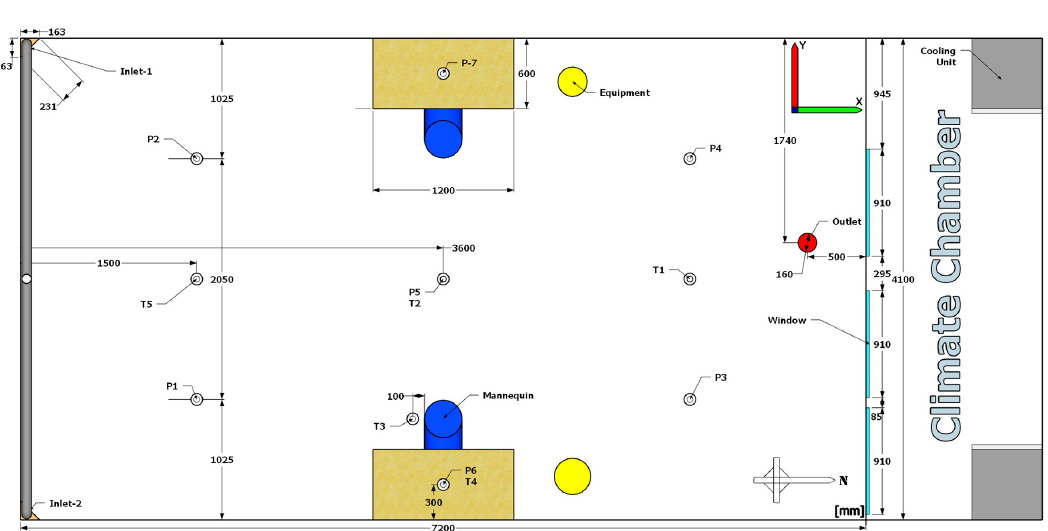
Figure 2. Measurement positions and schematic top view layout of office room and the climate chamber. Table 2. Energy balance overview of the office room.